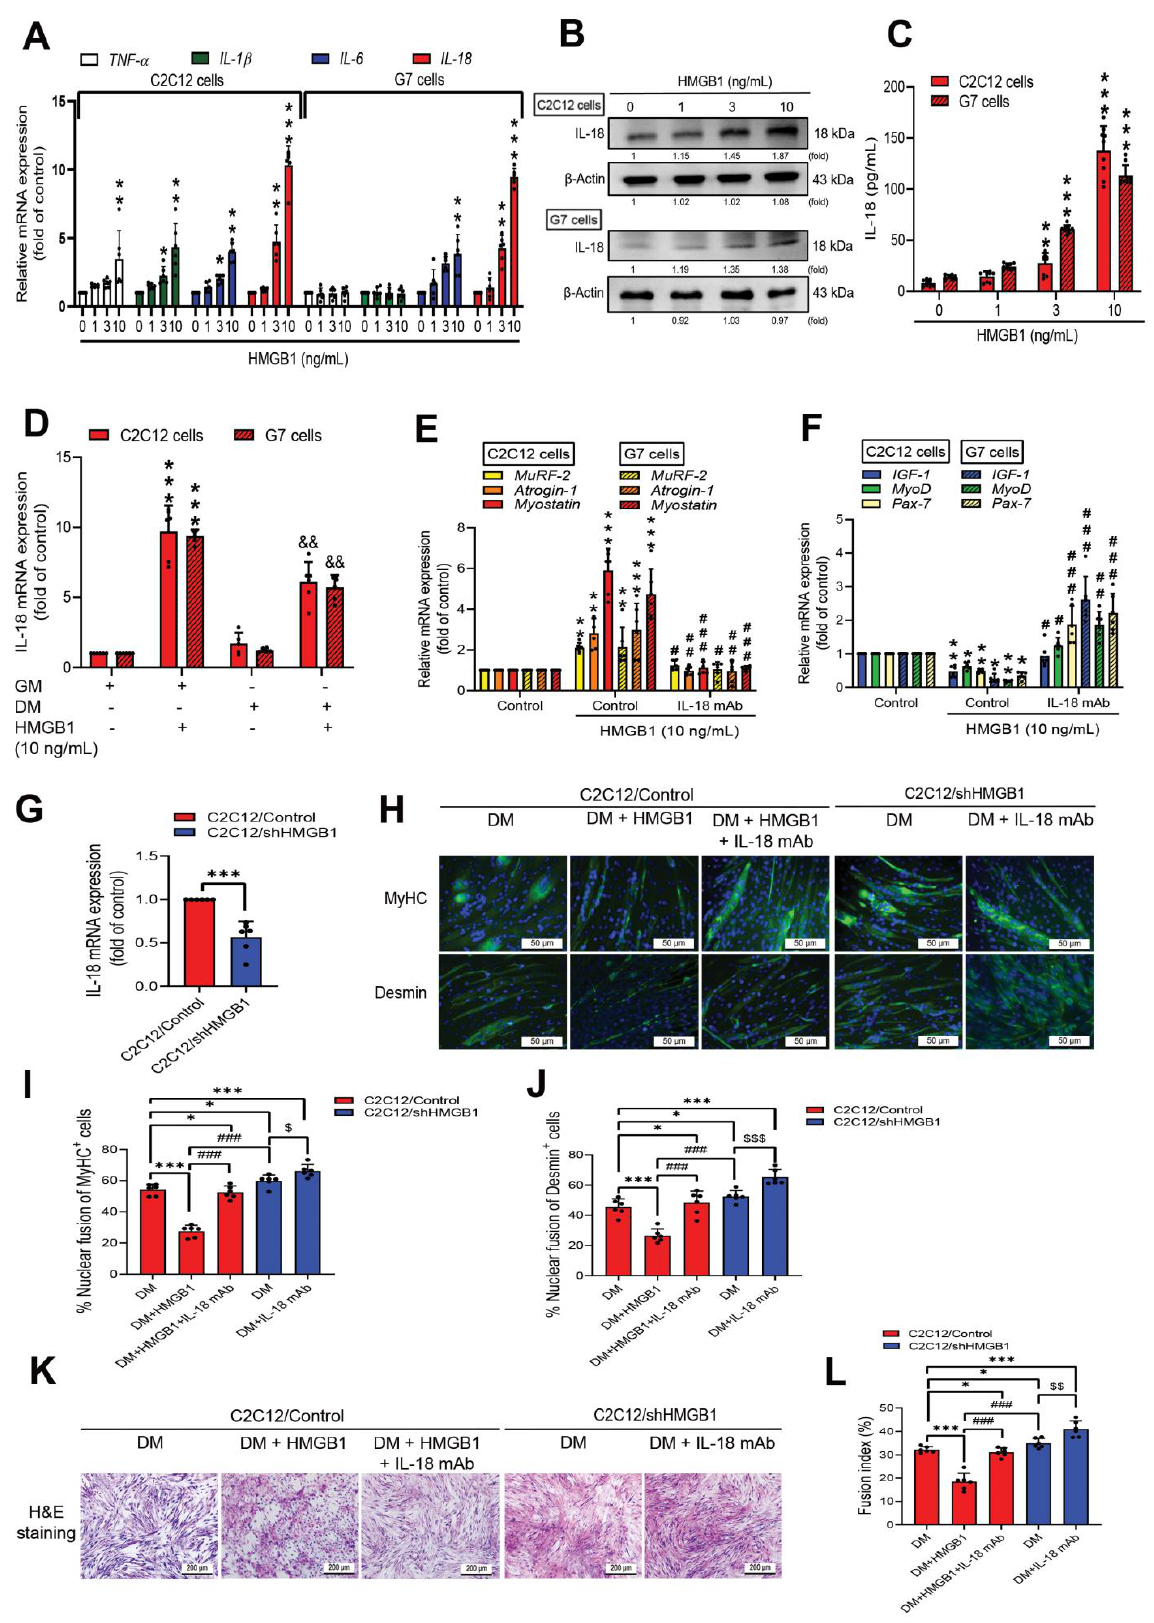
Figure 2. HMGB1 inhibits myoblast differentiation via an IL-18-dependent mechanism. ( A ) Level of mRNA expression of inflammatory cytokines in C2C12 and G7 myoblast cells after treatment